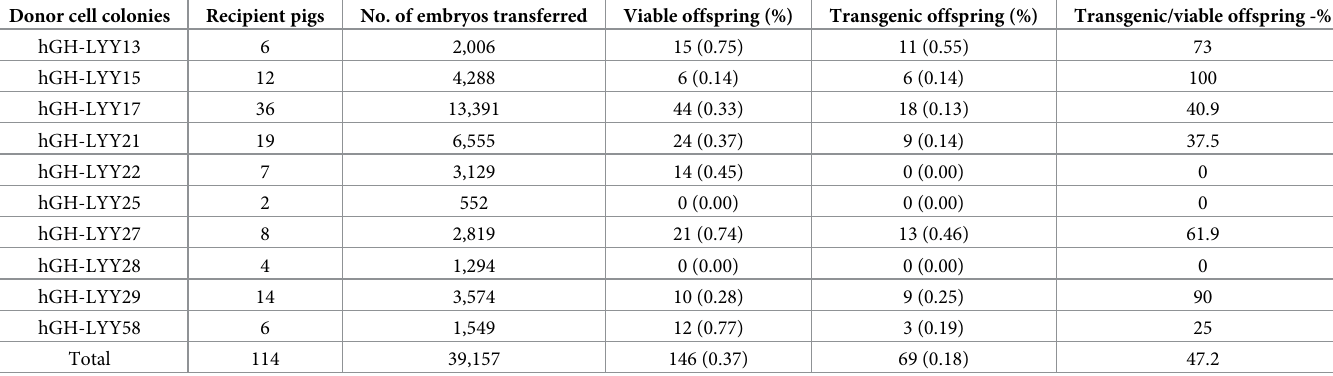
Table 3. Transgenic cloned embryos: Transfer result. Donor cell